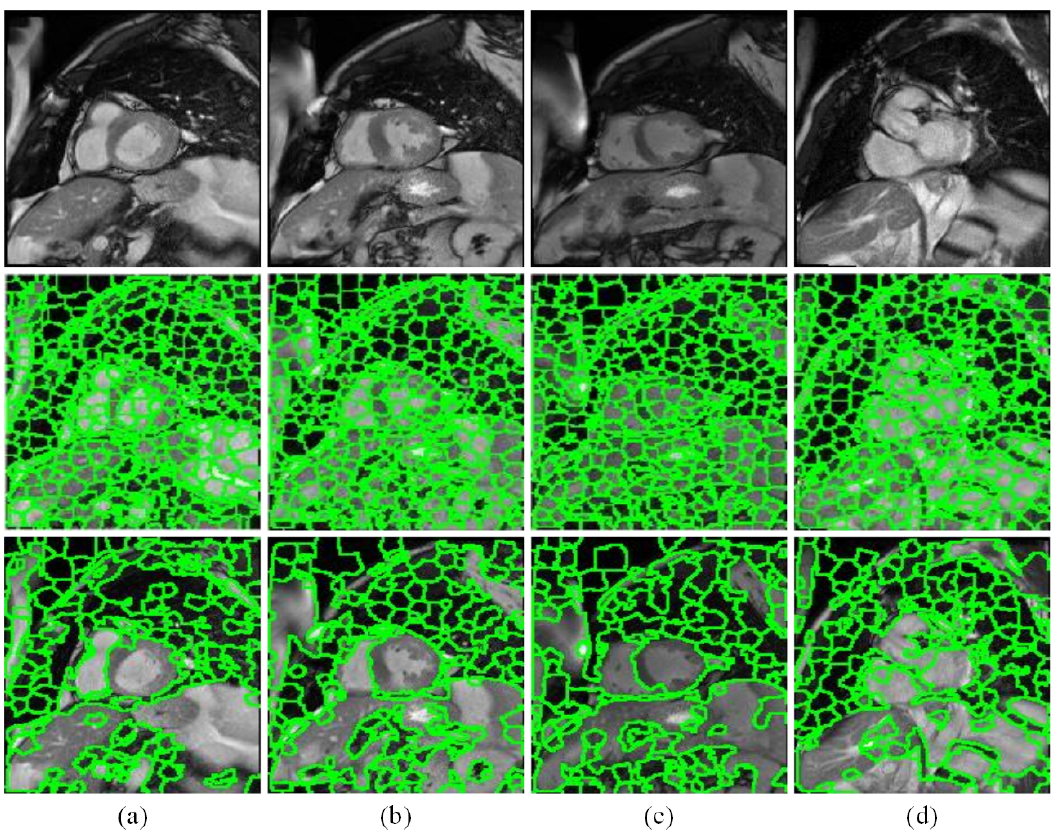
Figure 5. Candidate region generation results. ( a – d ) are four examples. From top to bottom are the original images, initial superpixel segmentation images, and proposed candidate region